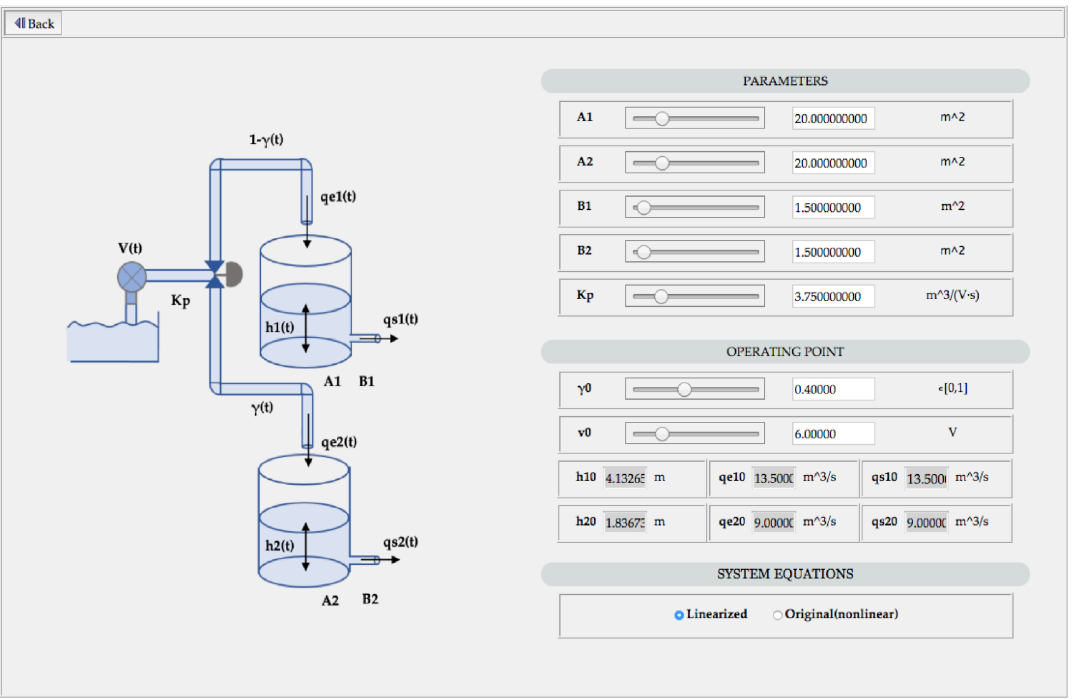
Figure 5. Configuration of the parameters and operating